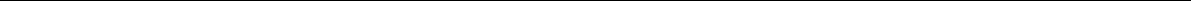
Fig. 1 ZnFn2 mutant tumors are frequently observed in luminal B breast cancers and have worse survival. a GATA3 mutations associate with favorable prognosis. Histogram shows distribution of GATA3 expression in the METABRIC cohort (left). Patients are categorized into low (<8) or high (>9.5) GATA3 expression group, and these groups were applied for Kaplan – Meier survival analyses (10-year survival). High GATA3 expression cases were used for the survival analysis shown in right panel. Log rank p -values are indicated in the panels. b Distribution of GATA3 mutations found in breast tumors. The mutation data was obtained from the METABRIC cohort via the cBio Cancer Genomics Portal. The positions of zinc- fi nger motifs were obtained from the Uniprot database 42 . c , d Subtype frequency in each GATA3 expression/mutation class. The PAM50 classi fi ed subtypes were used to generate pie charts. e Kaplan – Meier 10-year survival analyses of patients expressing GATA3 mutations. “ Other GATA3 mutations ” indicates the cases that possess any GATA3 mutations other than ZnFn2 mutations. Log rank p -values are indicated in the panels. Higher GATA3 expression cases were used to generate the survival